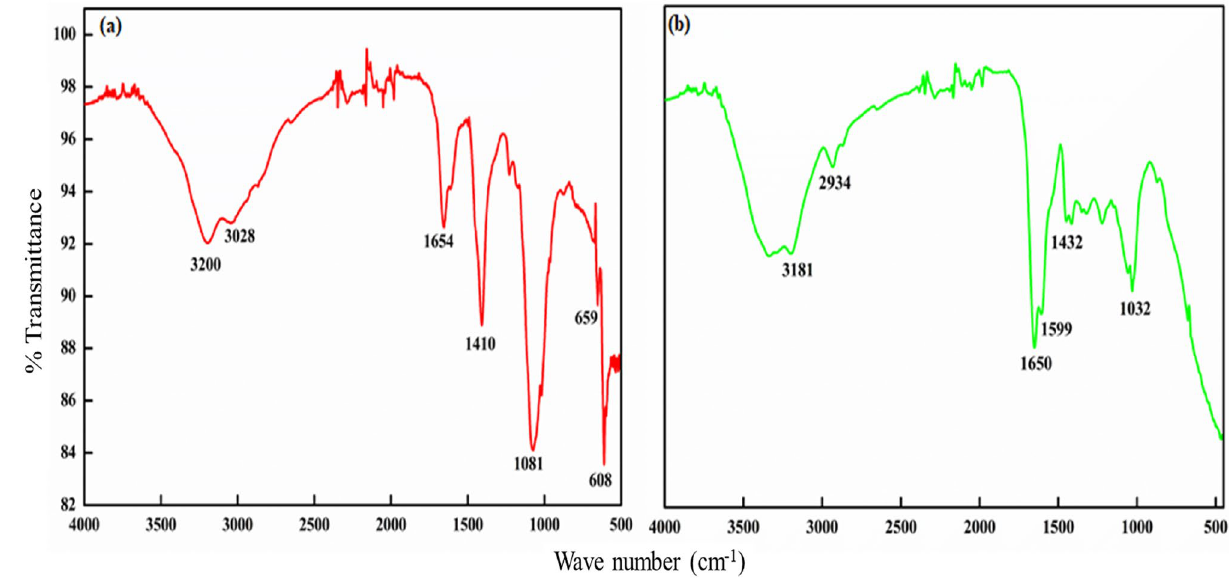
Figure 1. FTIR spectra of ( a ) GG-PAAm/Er 2 O 3 nanocomposite, and ( b ) NB-loaded